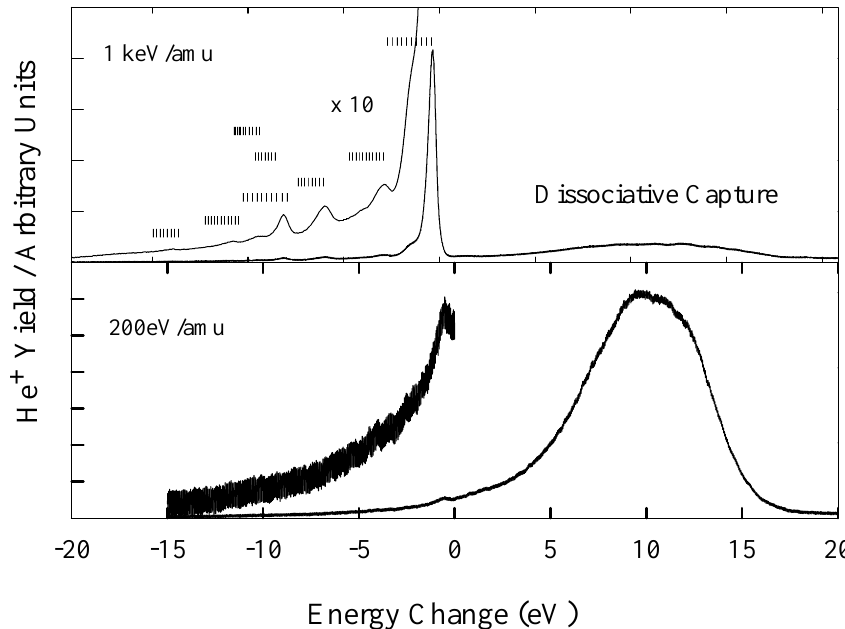
Figure 8: Translational energy spectra obtained for He 2+ ions in CO at energies of 200 eV/amu and 1